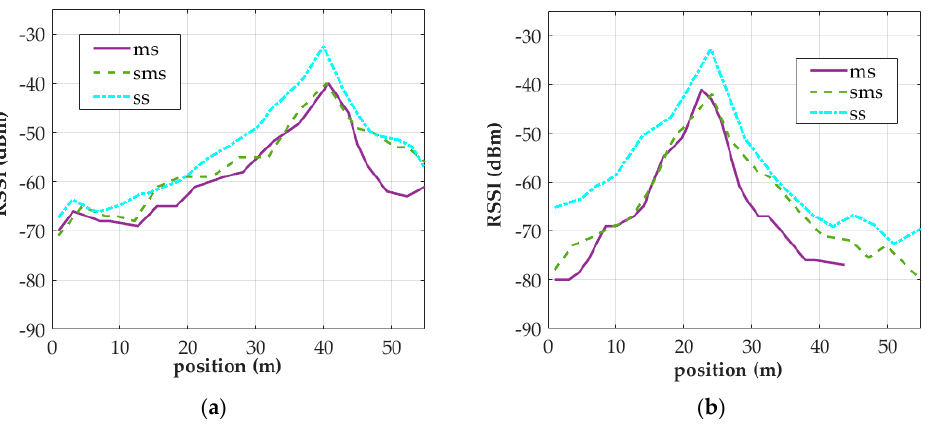
Figure 11. RSSI distributions of signals collected at the 5-GHz band by using different APs (the distributions were derived through the NVA algorithm). ( a ) AP1; ( b )